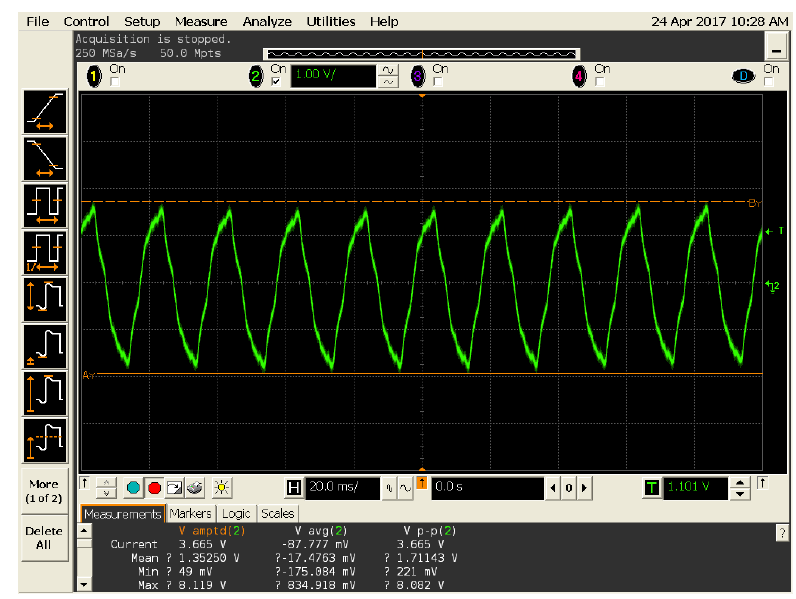
Figure 13. Trojan-inserted readings of the C101 Capacitor Charging and Discharging.